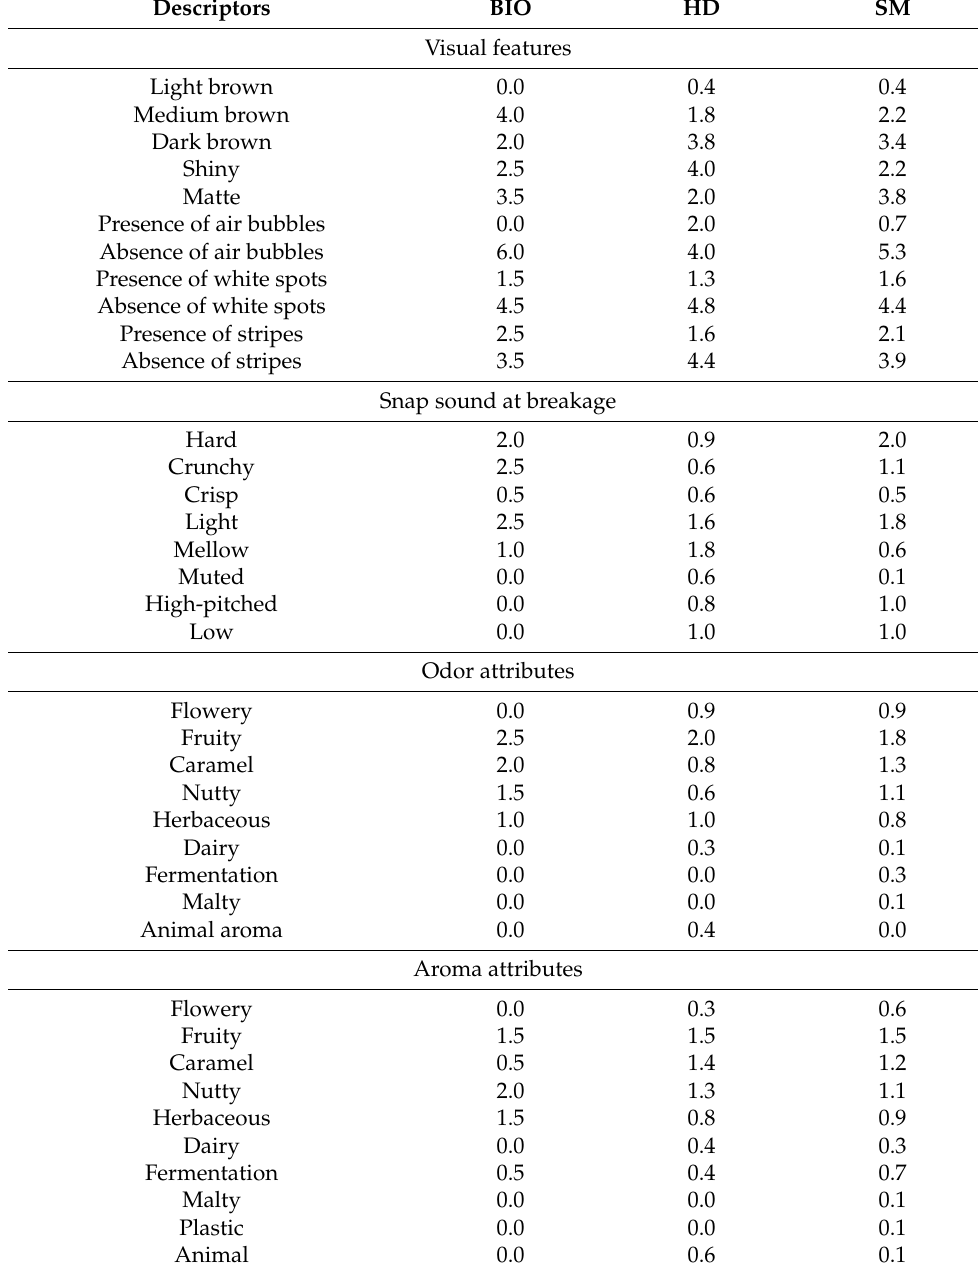
Table 5. Average scores of the panel test (6 untrained panelists) evaluation descriptors for the organic (BIO, 2 samples), hard discount (HD, 8 samples), and supermarket (SM, 14 samples)